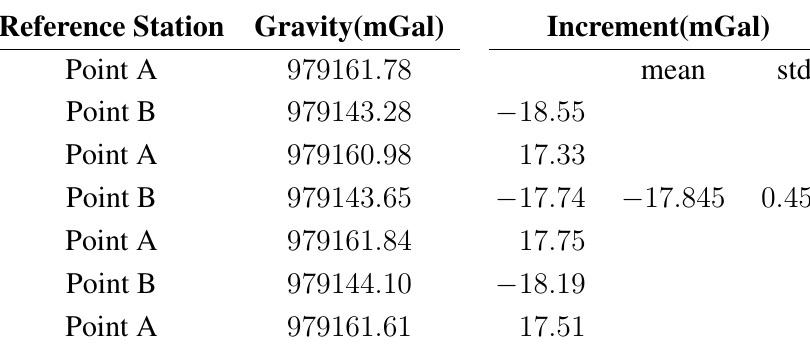
Table 3. Result of road test of